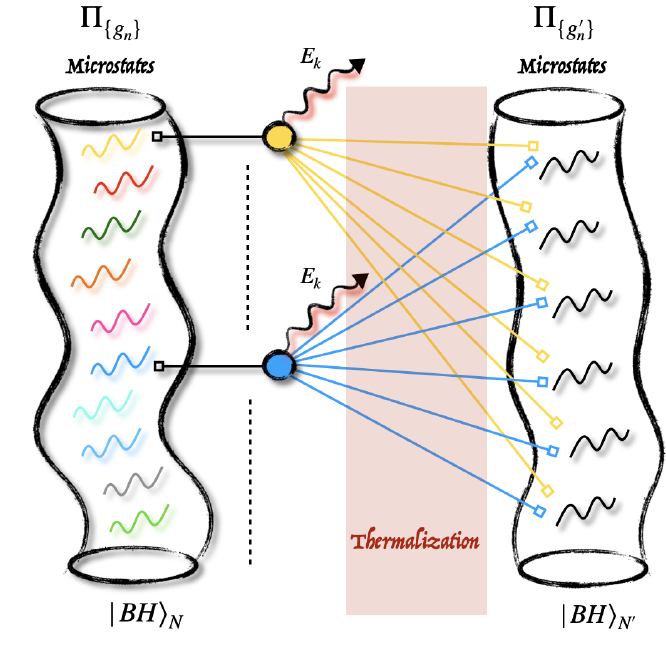
Figure 8 . Qualitative picture of the decay rate | BH i N ⇒ | BH i N 0 + E k . The microstates of the decaying state are represented by colorful small strings, each color is associated to the possible microstate decay. The red region represents the random superposition of all the possible decays which is the mechanism through which the thermalization process